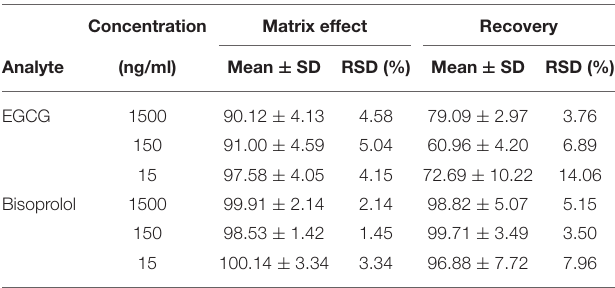
TABLE 3 | Extraction recovery and matrix effect for the EGCG and Bisoprolol in plasma (mean ± SD, n = 6). Concentration Matrix effect